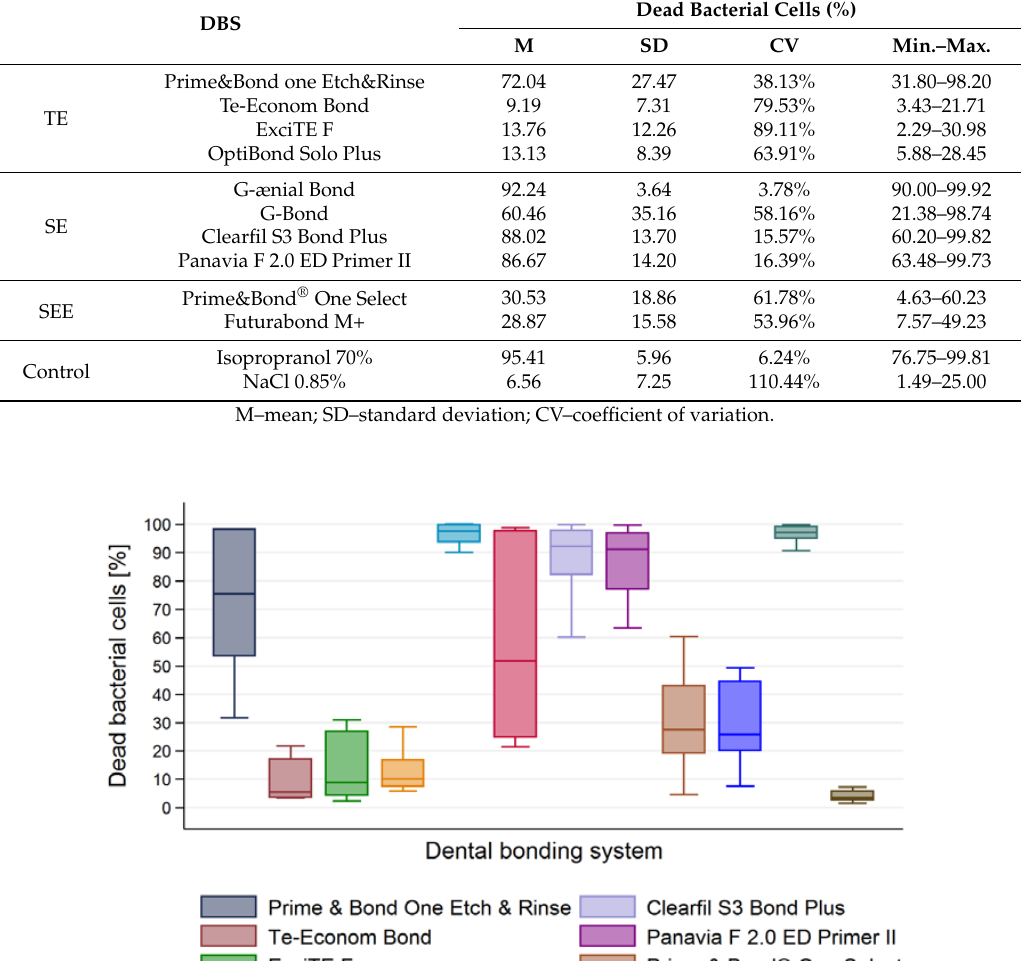
Table 1. Antibacterial activity of DBS against E. faecalis -Statistical parameters.